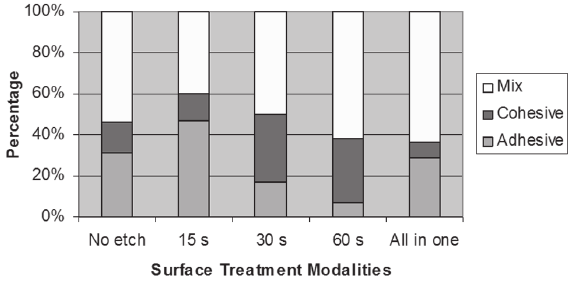
Figure 4- Fracture modes of the specimens bonded to Ketac Molar Quick Applicap according to various surface treatment modalities